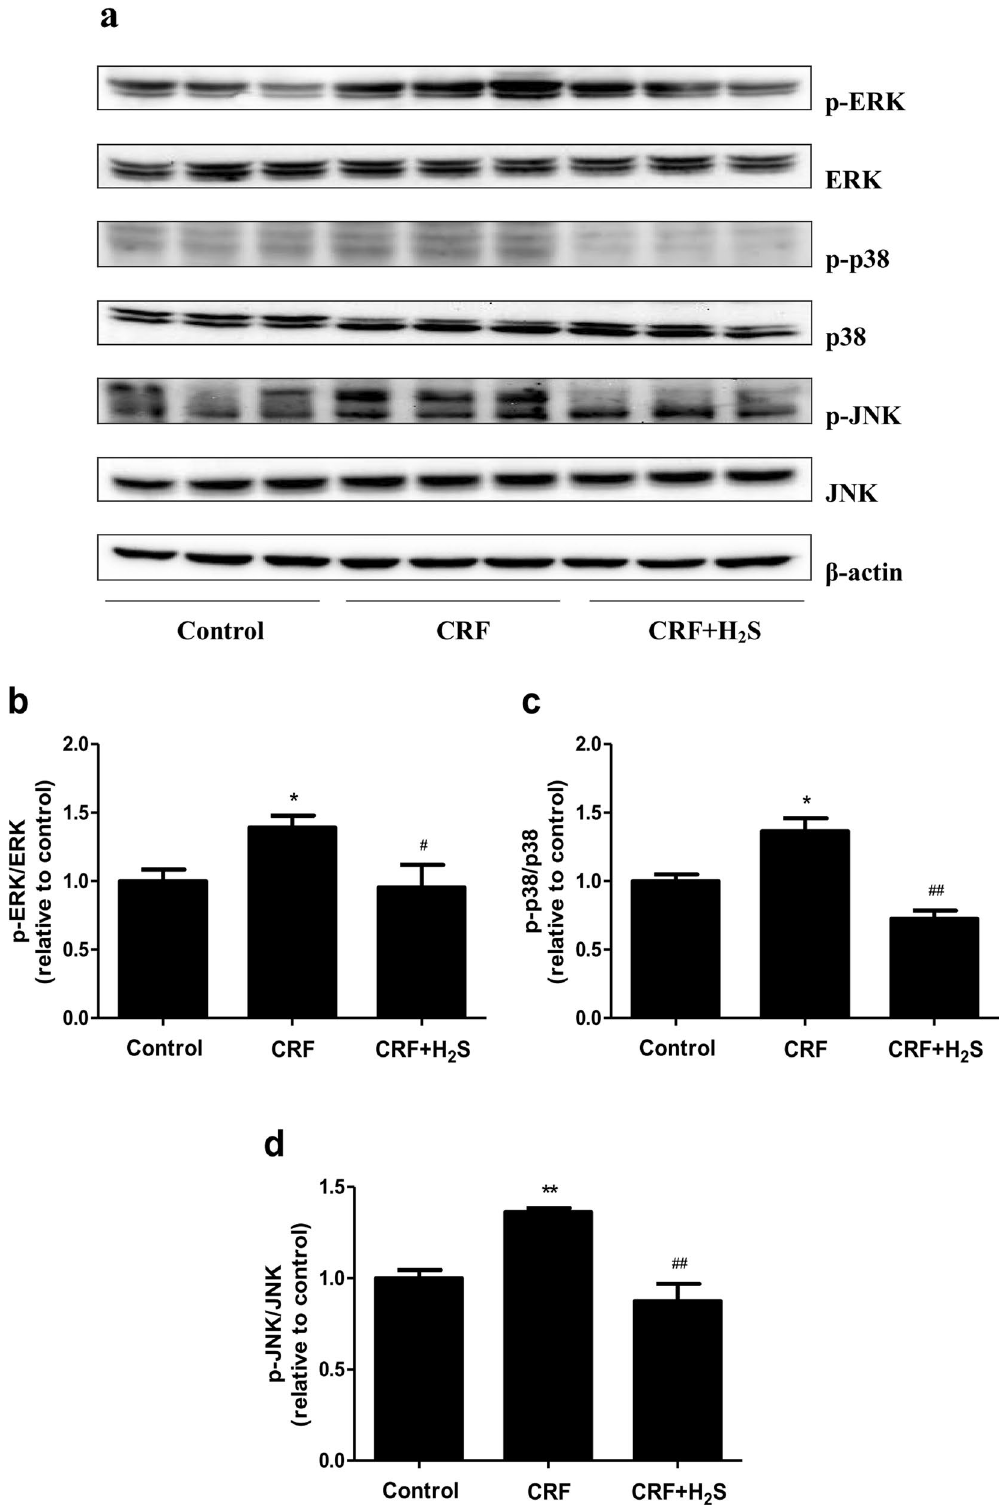
Figure 8. Effects of H 2 S on the MAPK pathway in the kidney of CRF rats. ( a ) The expression levels of p-ERK, ERK, p-p38, p38, p-JNK, and JNK were detected by Western blot. β -actin was used as an internal control. Bar graphs showed the quantification of p-ERK/ERK ( b ), p-p38/p38 ( c ), and p-JNK/JNK ( d ). Values were presented as mean ± SEM (n = 3); * P < 0.05, ** P < 0.01 compared with the control group; # P < 0.05, ## P < 0.01 compared with the CRF